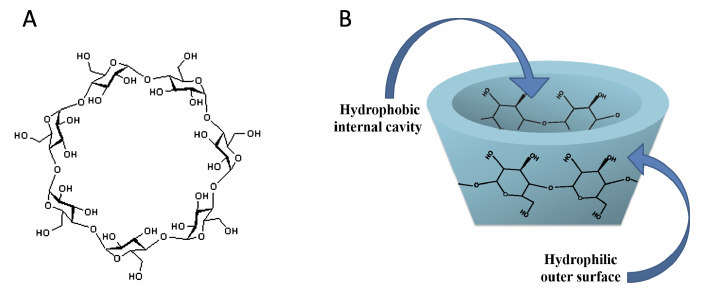
Figure 1. β -CD molecule: ( A ) chemical structure, and ( B ) toroidal shape.